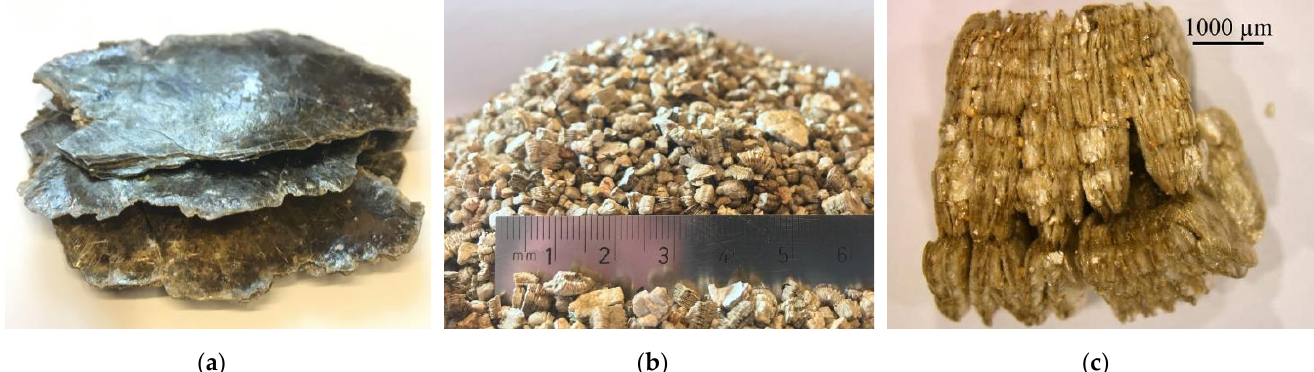
Figure 3. Vermiculite ( a ); raw vermiculite; ( b ) exfoliated vermiculite fraction 2/4 mm; ( c ) exfoliated vermiculite pellet. The apparent density of lightweight aggregates varies greatly (from 400 to 2000 kg/m 3